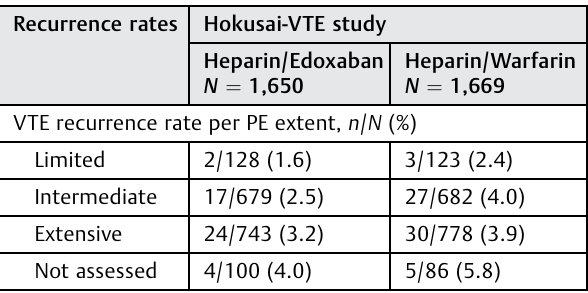
Table 4 Correlation between anatomical extent of PE